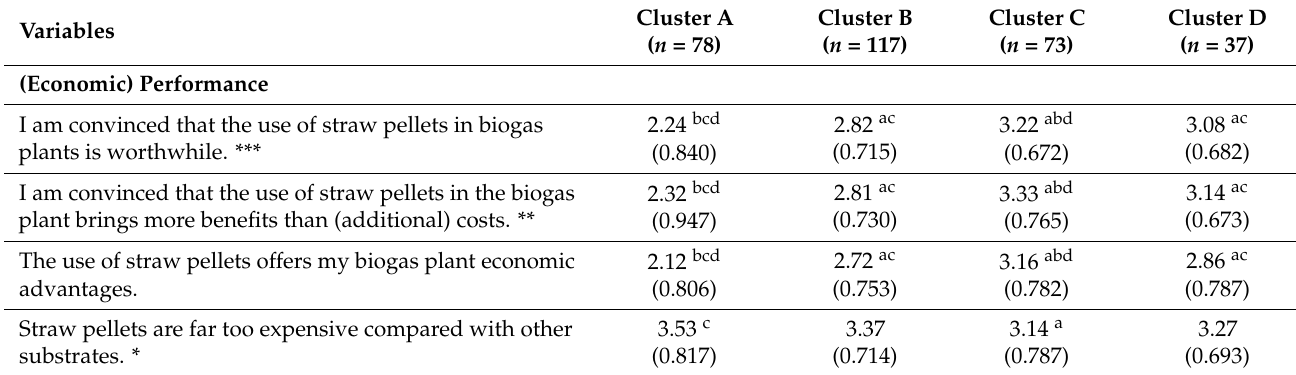
Table 4. Cluster description: Characteristics of the